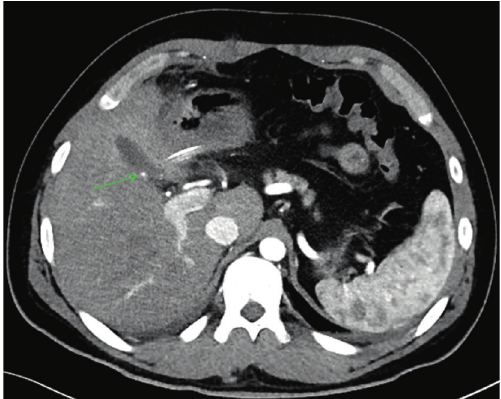
Figure 2: Contrast-enhanced computed tomography scan of the abdomen in the axial plane showing a cystic artery pseudoa- neurysm (green